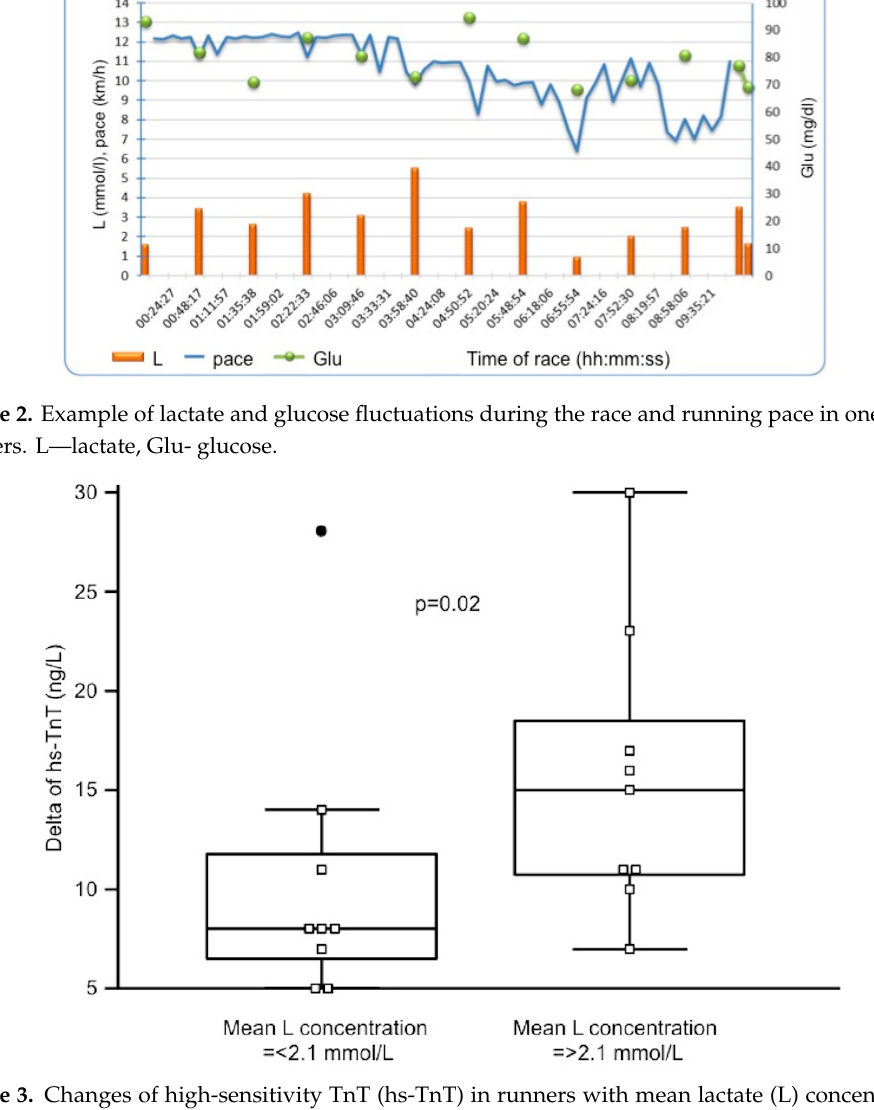
Figure 3. Changes of high-sensitivity TnT (hs-TnT) in runners with mean lactate (L) concentration during the race below and above the median. A black dot on the left is an outstanding result in one of the runners.